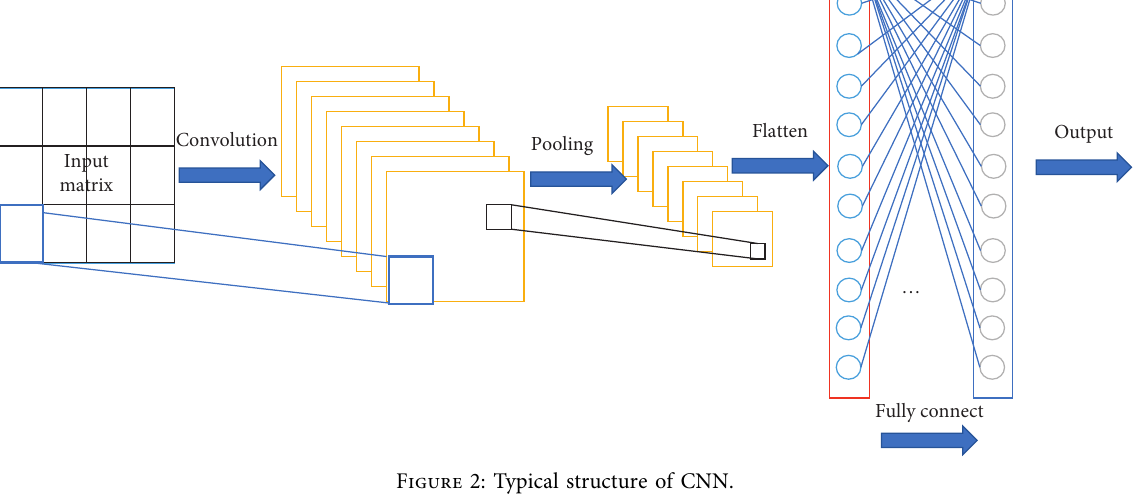
Figure 2: Typical structure of